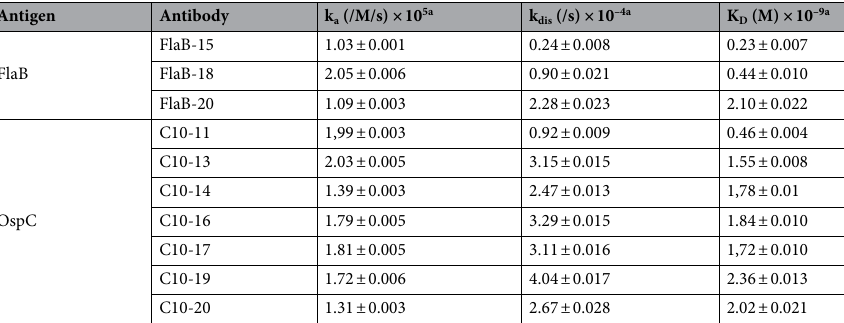
Table 1. Kinetic parameters of mAbs for flagellin B and OspC proteins. Mean and standard deviation values of equilibrium dissociation constant (K D ), association rate (k a ) and dissociation rate (k dis ) were extracted from the curve-fitting analysis of mAb association and dissociation successive dilutions (out of 7). a Values determined by the Octet Data Analysis HT 10.0 software using a 1:1 binding model, and expressed as mean ±